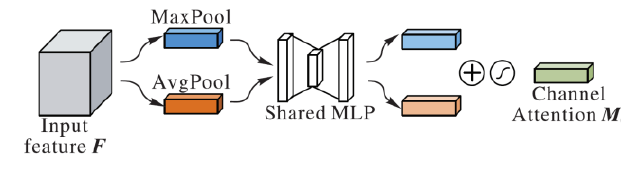
Figure 3. Channel attention module